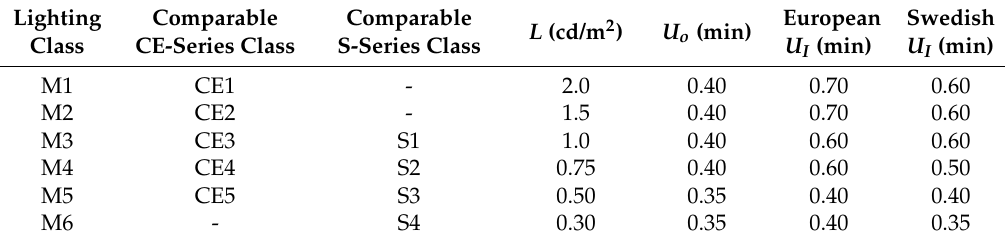
Table 2. European and Swedish lighting classes M1–M6, comparable European Standard CE-series and S-series classes [21], average road surface luminance ( L , cd/m 2 ) and minimum (min) values of U o (overall luminance uniformity) and U I (longitudinal luminance uniformity) according to European and Swedish Standards [16,17].